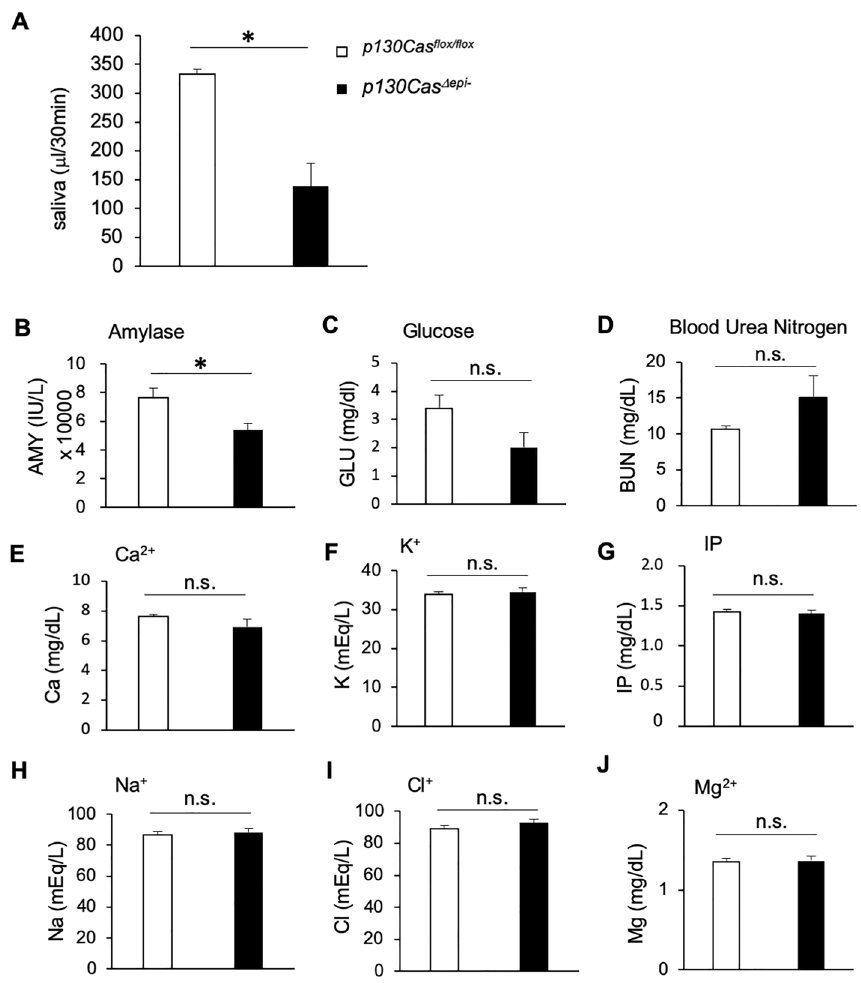
Figure 3. The dysfunction of salivary glands in p130Cas Δepi– mice. ( A ) The total volume of pilocarpine- induced saliva secretion in 30 min in P35 p130Cas flox/flox and p130Cas Δepi– mice. ( B – D ) The amounts of organic components of saliva, amylase ( B ), glucose ( C ), and blood urea nitrogen ( D ) were measured. ( E – J ) The inorganic component of saliva, Ca 2+ ( E ), K + ( F ), Na + ( G ), Mg 2+ ( H ), Cl – ( I ), and IP (inorganic phosphorus) ( J ) were measured. p130Cas flox/flox n = 10 mice, p130Cas Δepi- n = 7 mice. Data show the means ± SEM, * P < 0.05 versus the corresponding p130Cas flox/flox